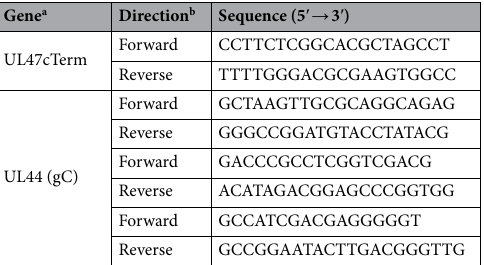
Table 1. Primers used for sequencing. a Gene sequenced with the set of primers. b Directionality of the primer.